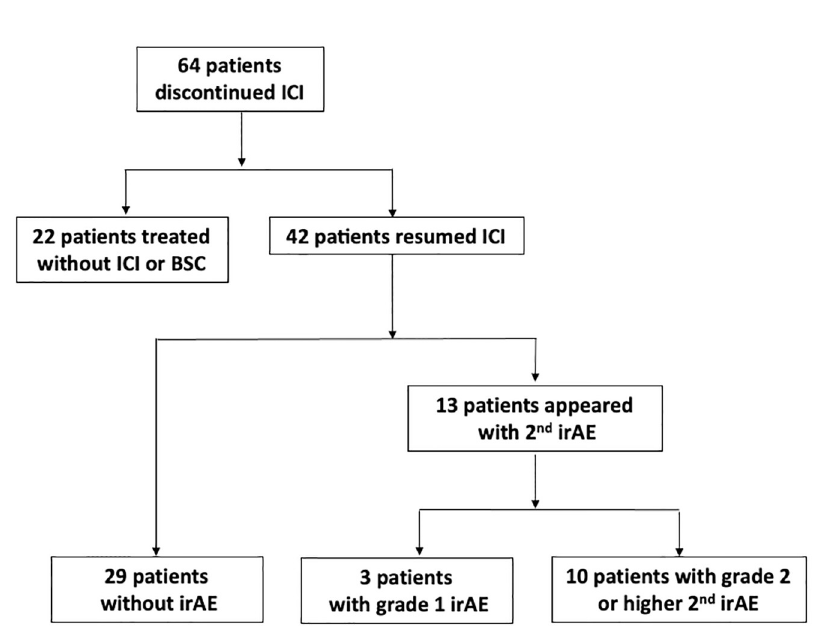
Fig 2. Flow diagram of irAE resumption. ICI: immune checkpoint inhibitors, irAE: immune-related adverse event.